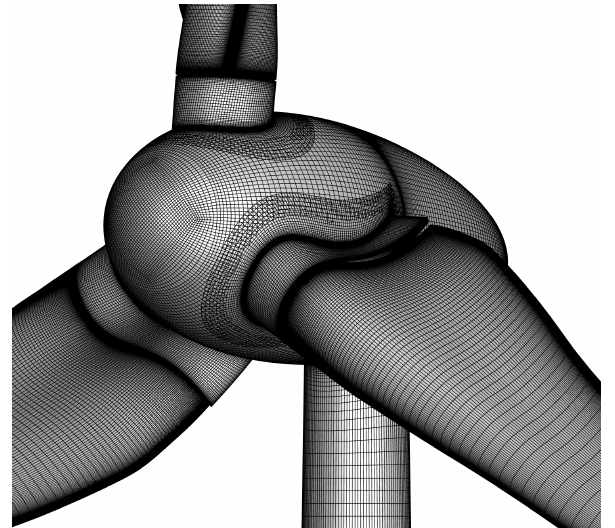
Figure 5. CFD surface mesh of the hub region, showing mesh over-